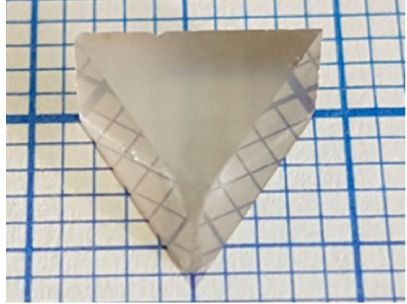
Figure 12. Prism for measuring the refractive indices of the LYSB crystal. (Reprinted with permission from ref. [13], copyright 2019 American Chemical Society).